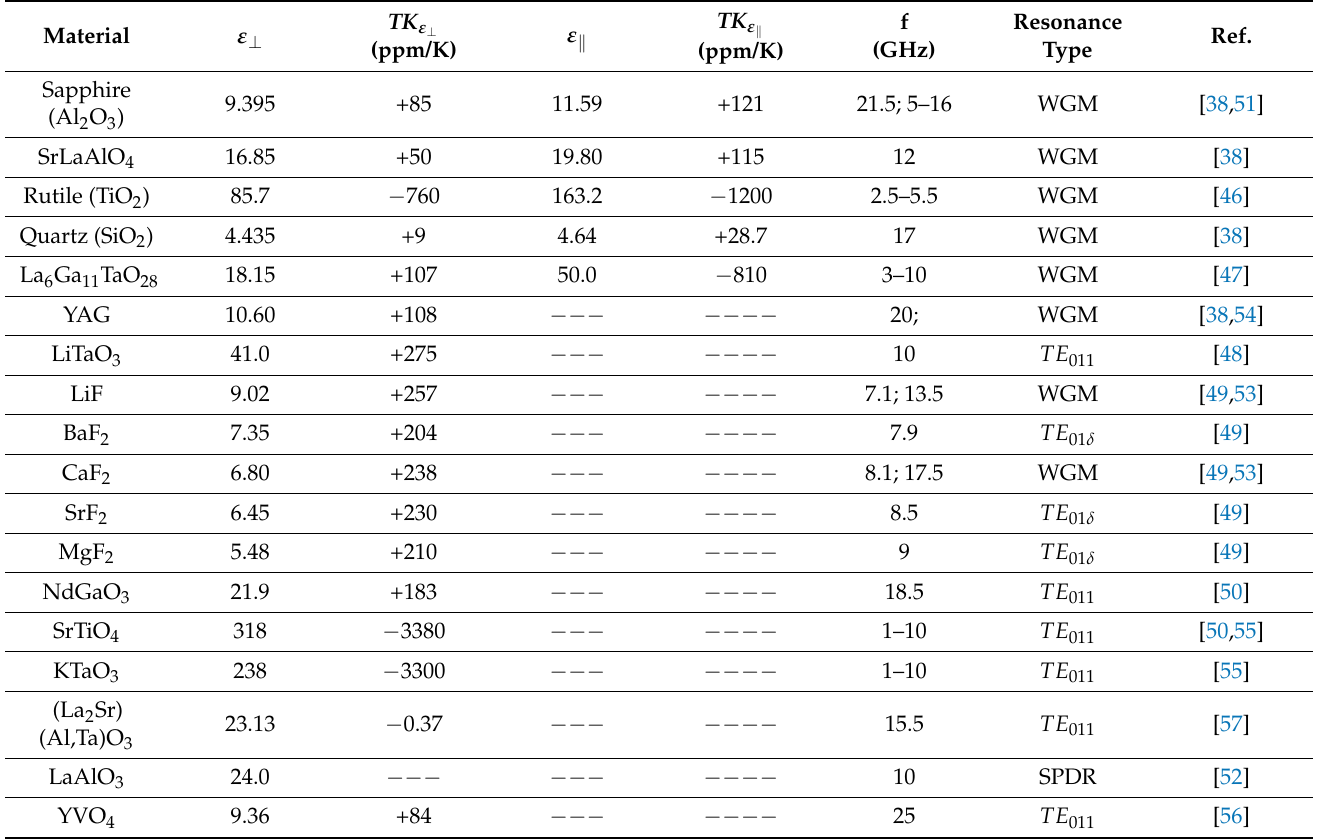
Table 1. Permittivity of some dielectric single crystals at T = 300